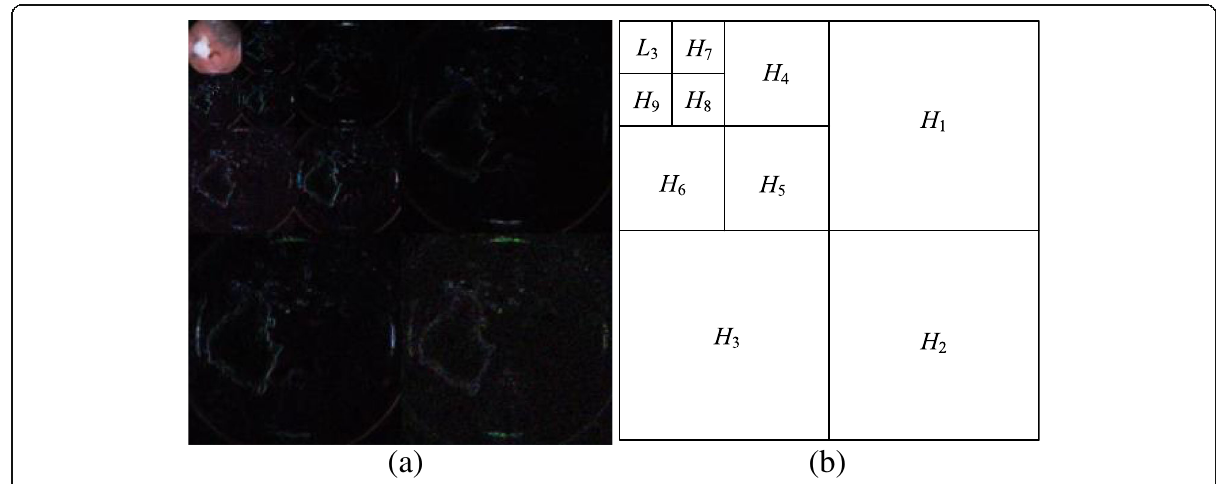
Fig. 3 A schematic diagram of the case image Q of a three-level wavelet decomposition: a case image of wavelet decomposition and b schematic diagram of a three-level wavelet